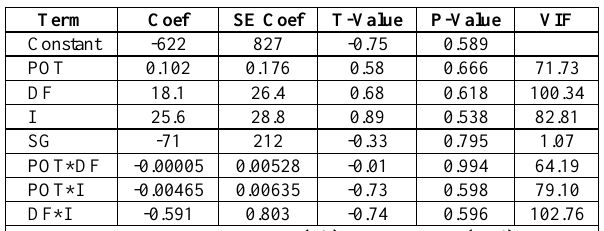
Table 3. Estimated regression coefficient for